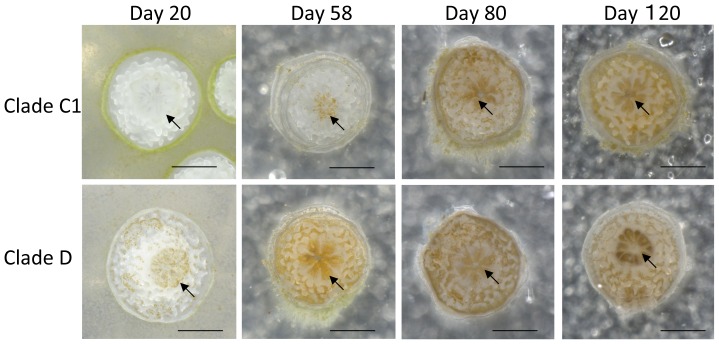
Juvenile polyps of Acropora tenuis colonized by clade C1 or clade D Symbiodinium monoclonal cells.Photographs of polyps were taken 20, 58, 80, and 120 days after inoculation. On day 20, polyps had only a few clade C1 cells but many clade D cells in their tentacles and body walls. The arrow indicates tentacles. Scale bar = 0.5 mm.